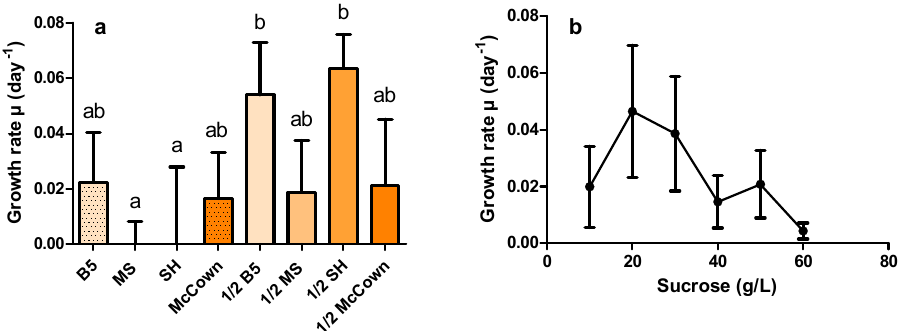
Figure 2. Effects of media and sucrose concentration on HR growth rate: ( a ) effect of various standard media and 1/2 dilutions, with 3% sucrose on the growth rate of line 16C; and ( b ) effect of sucrose concentrations in B5 medium on the growth of line 19A. Average growth rate µ and its standard error were calculated from weight measurements made over 35 days with renewal of culture media every three or four days. Each point is composed of three biological replicates. Statistical differences were tested using ANOVA ( α = 5%). Letters above dataset point out statistically different groups. A preference for 1/2 media seems to occur regardless of the medium tested (Figure 2a). Only the B5 and MC media enabled growth when non-diluted. Amongst the 1/2 media, it would seem that the SH medium yielded the best growth rate (µ), reaching µ = 0.063 day − 1 (doubling time, Td = 10.9 days), along with B5. Determination of the growth rate using different sucrose concentrations in the B5 medium (Figure 2b) showed that the range of 1% to 3% sucrose concentrations in the medium seems to bethe most effective, reaching a growth rate of 0.046 day − 1 (doubling time Td = 14.9 days) for 2%